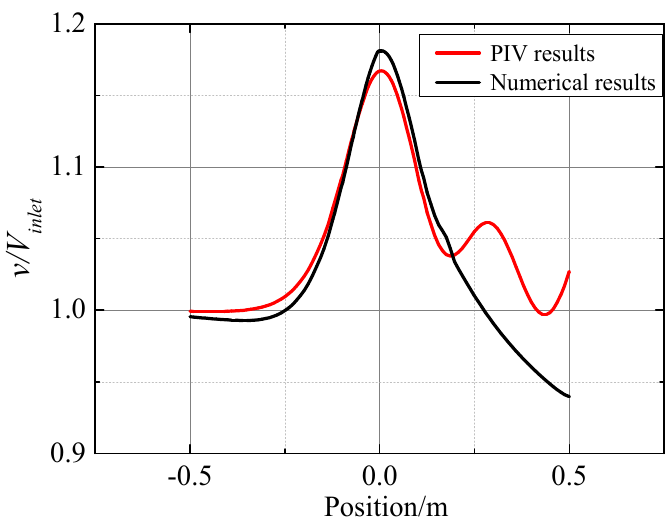
Figure 5. Comparison of calculation and PIV experiment results.